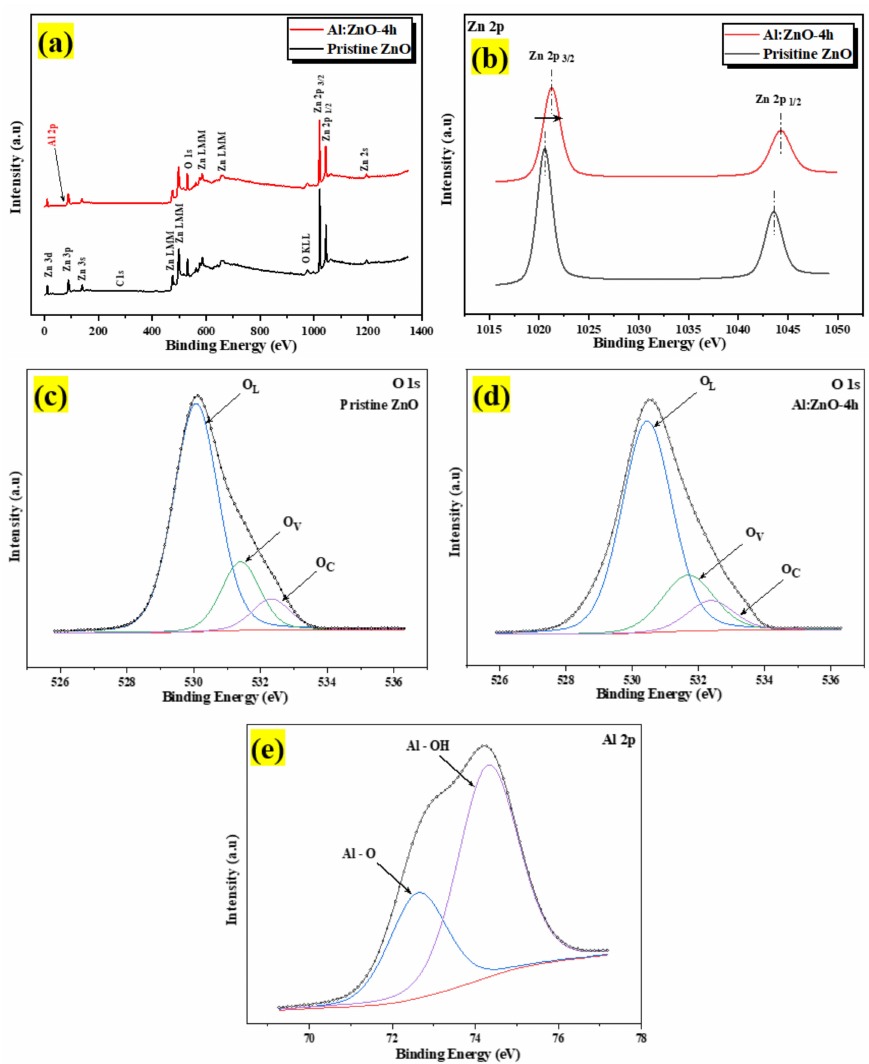
Figure 10. The XPS spectra of the pristine ZnO and Al:ZnO-4 h nanostructured powder: ( a ) Full survey scan spectra. High-resolution spectra of ( b ) Zn 2p region; ( c ) O 1s region for pristine ZnO; ( d ) O 1s region for Al:ZnO-4 h; and ( e ) Al 2p region of Al:ZnO-4 h. The high-resolution O 1s core energy-level spectrum for pristine ZnO and Al:ZnO-4